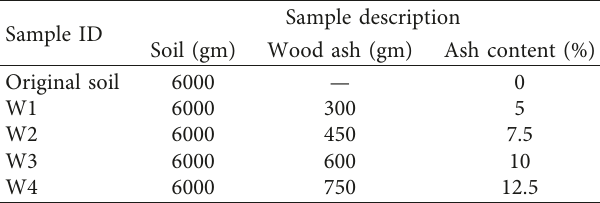
Table 3: Combination scheme of soil samples. Sample